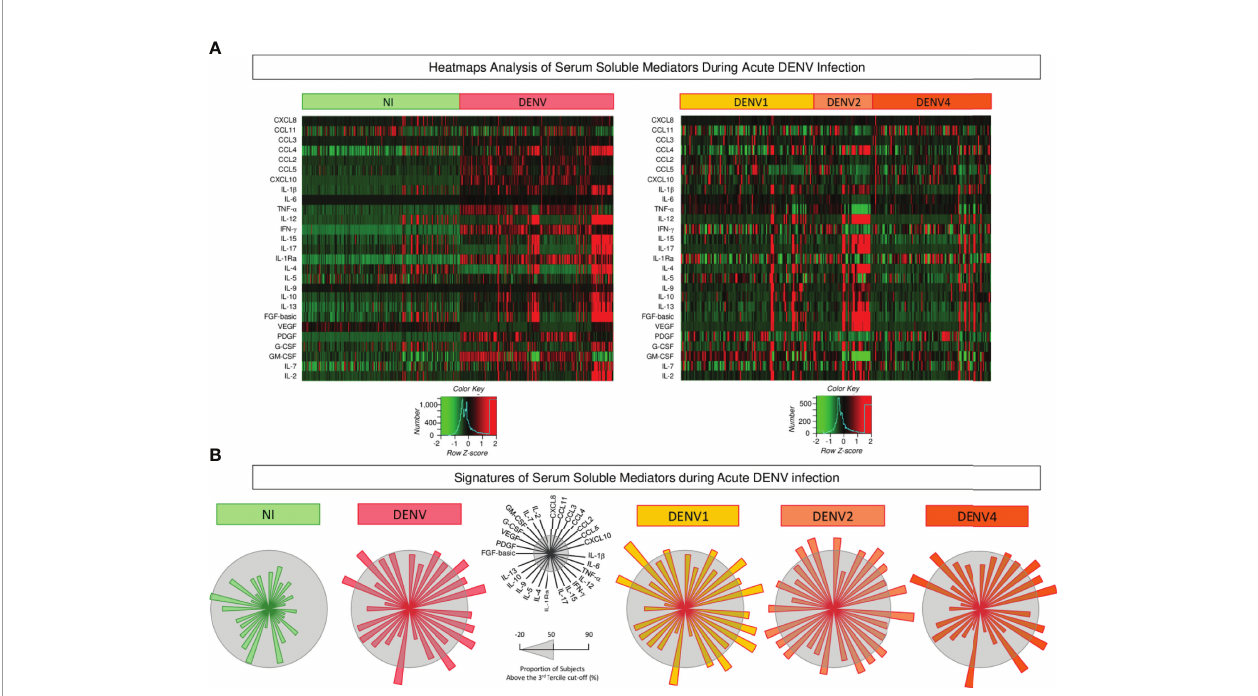
FIGURE 3 | Heatmap analysis and signatures of serum soluble mediators during acute DENV infection. (A) Heatmap constructs of soluble mediators de fi ned to cluster pro fi les of chemokines (CXCL8, CCL11, CCL3, CCL4, CCL2, CCL5, CXCL10), pro-in fl ammatory cytokines (IL-1 b , IL-6, TNF- a , IL-12, IFN- g , IL-15, IL-17), regulatory cytokines (IL-1Ra, IL-4, IL-5, IL-9, IL-10, IL-13), and growth factors (FGF-basic, PDGF, VEGF, G-CSF, GM-CSF, IL-7, and IL-2) observed in serum samples from patients with acute DENV infection – “ DENV ” ( n=319), further classi fi ed according to the DENV serotypes (n=269) into: DENV1 ( n=116), DENV2 ( n=52), DENV4 ( n=101) as compared to the reference non-infected healthy controls – “ NI ” ( n=319). The soluble mediators were measured by a high-throughput microbeads array as described in the Material and Methods section. The individual levels of serum soluble mediators (attributes), expressed in pg/ mL, were used to calculate the Z-score for each attribute and further generation of heatmap constructs. The Row Z-score scaled from − 2 to 2 is illustrated as de fi ned in the color key gradients provided in the Figure. (B) Overall signature of chemokines, pro-in fl ammatory cytokines, regulatory cytokines, and growth factors assembled for patients with acute DENV infection – “ DENV ” , further classi fi ed according to the DENV serotypes as: DENV1, DENV2, and DENV4 as compared to the reference non-infected healthy controls – “ NI ” . Signatures of serum soluble mediators were built as described in Material and Methods, by fi rst converting the serum levels of soluble mediators, originally expressed as continuous variables (pg/mL) into categorical data (percentual, %) using the upper 3 rd tertile values of each serum mediator as the cut-off to identify the proportion of subjects above the cut-off edges. The fi nal data are shown in a radar chart, with each axis representing one serum mediator. The 50 th percentile (gray zone) was used to underscore the serum soluble mediators with increased proportion ( ≥ 50%) in each study